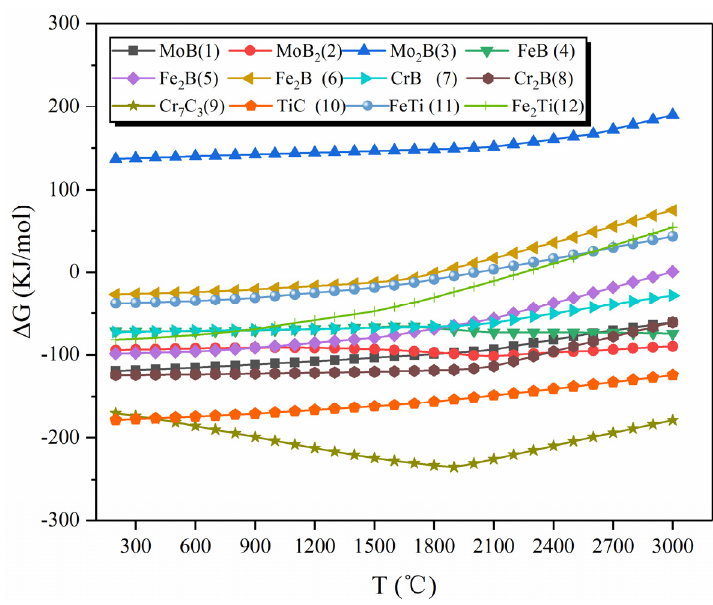
Figure 7. Effect of temperature on Δ G of each reaction